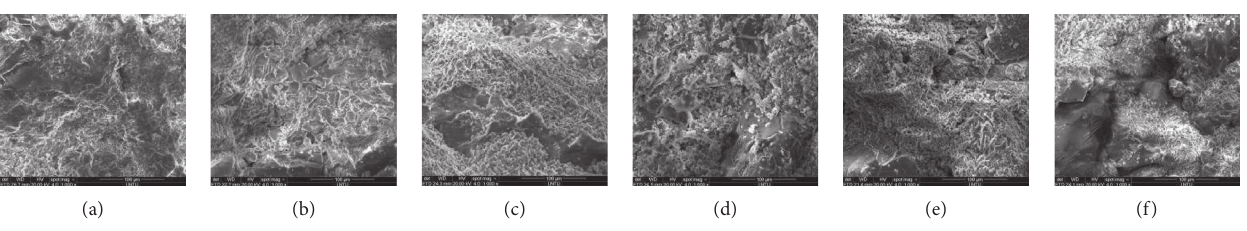
Figure 13: Microstructure of the feldspar sandstones (Group B) after the dry-wet cycles. (a) 0T. (b) 5 T. (c) 10T. (d) 15 T. (e) 20T. (f)